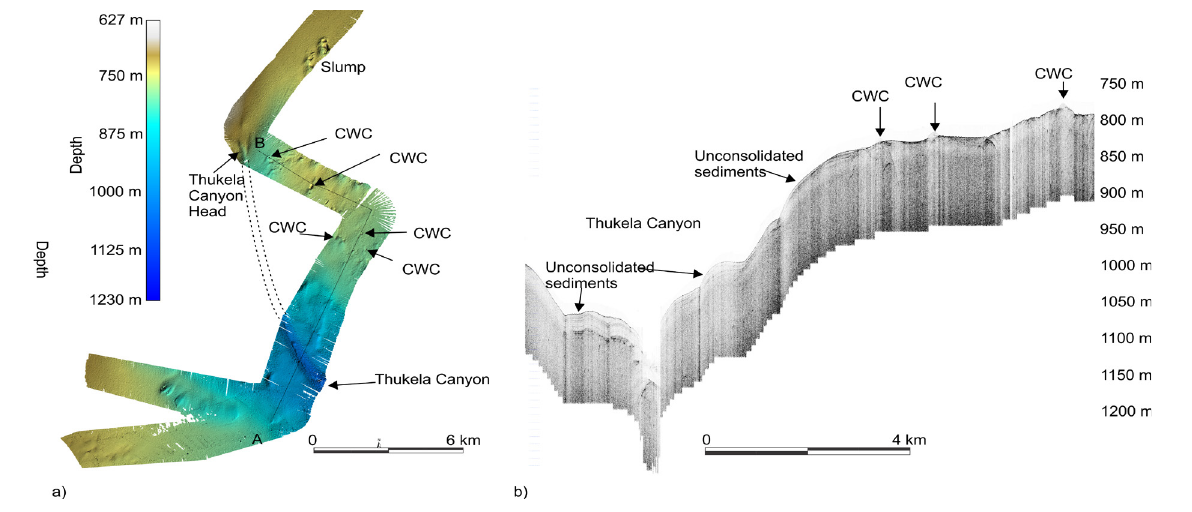
Figure 5: (a) Multibeam bathymetry of the seabed surrounding the Thukela Canyon head with circular seafloor peaks. (b) Seismic reflection profile crossing the Thukela Canyon with suspected cold-water corals (CWCs) cropping out.